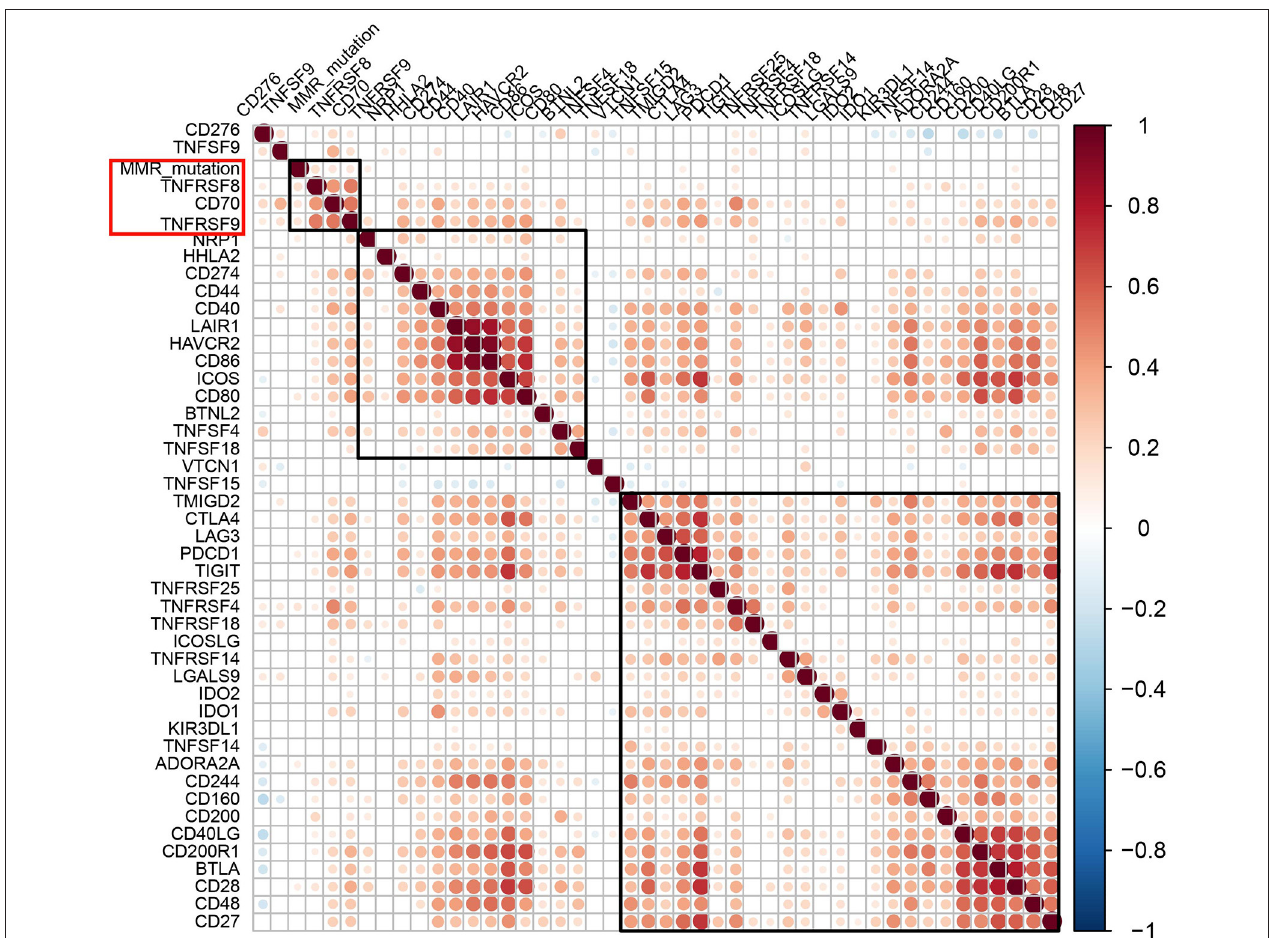
FIGURE 4 | Correlation heatmap between IGCs’ expression and mismatch repair (MMR) gene mutation. The blank shows non-significant correlation. Blue represents negative correlation, while red represents positive correlation. The larger the point and the redder the color, the stronger the